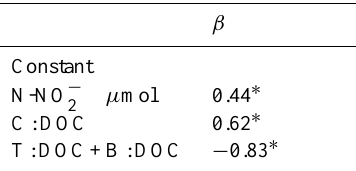
Table 4. Predictor variables and coefficients ( β) influencing the cal- culated five-day N 2 O:N 2